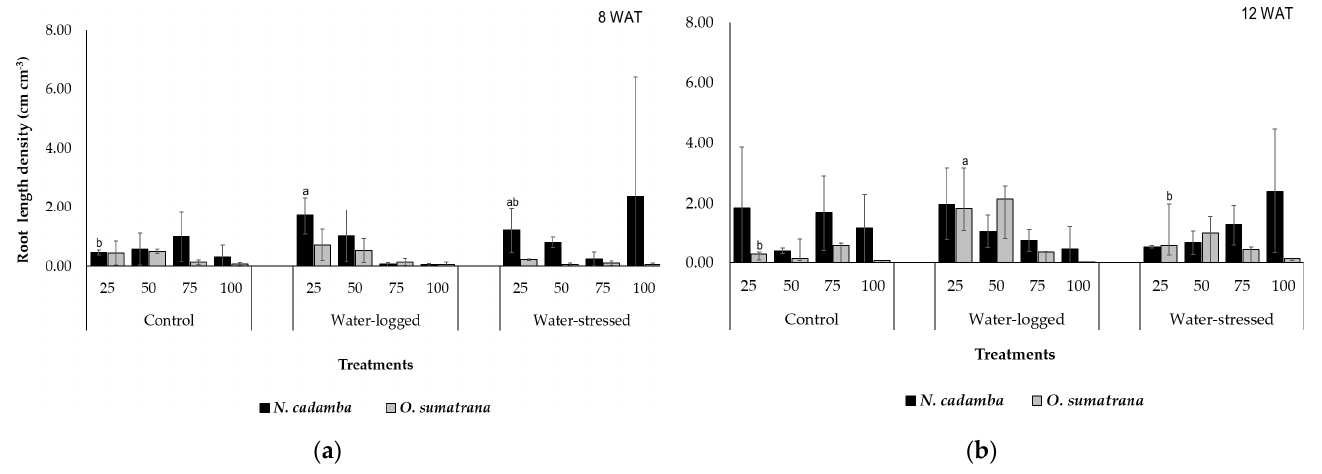
Figure 7. ( a ) Root length density (cm cm − 3 ) at 8 WAT under water-stress, water-logged, and control treatment for N. cadamba and O. sumatrana at different soil depths. A two-way ANOVA test was used, followed by Tukey’s HSD ( p < 0.05, n = 3). Error bars indicate standard deviation. Different letters indicate a significant difference between the various conditions for each depth tested. ( b ) Root length density (cm cm − 3 ) at 8 WAT under water-stress, water-logged, and control treatment for N. cadamba and O. sumatrana at different soil depths. A two-way ANOVA test was used, followed by Tukey’s HSD ( p < 0.05, n = 3). Error bars indicate standard deviation. Different letters indicate a significant difference between the various conditions for each depth tested.